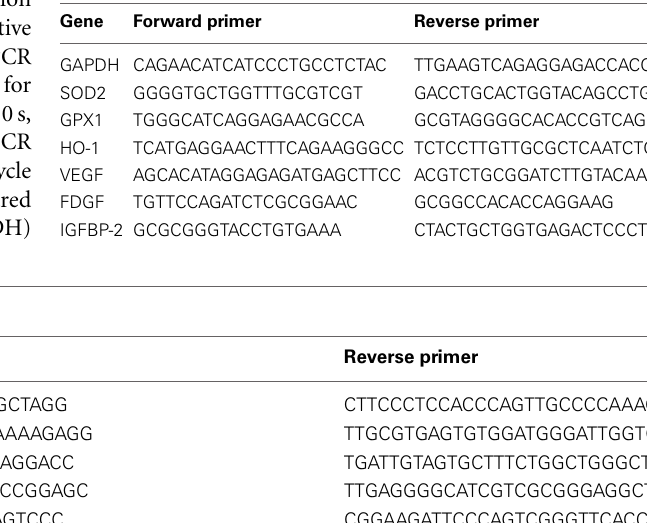
Abbreviations: WB, Western blot; IF, immunofluorescence; RT, room temperature. Table 3 | The sequences for the primers of quantitative real time RT-PCR.